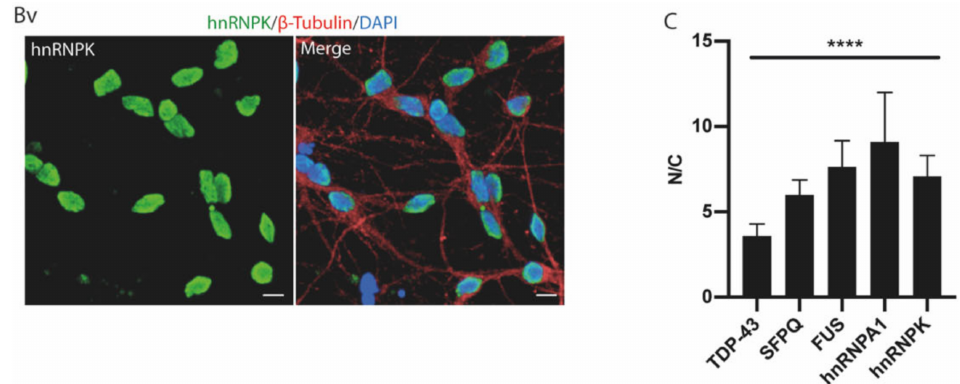
Figure 1. Localisation of amyotrophic lateral sclerosis (ALS)-linked RNA-binding proteins (RBPs) in human induced pluripotent stem cell (iPSC)-derived motor neurons. ( A ) Representative images of human iPSC-derived motor neurons immunolabeled with motor neuron markers SMI-32 and ChAT. Scale bars = 20 µ m. ( B ) Representative images of ALS-linked RBPs and neuronal marker β -III-tubulin in iPSC-derived motor neurons. Scale bars = 10 µ m. ( Bi ) TDP-43; ( Bii ) SFPQ; ( Biii ) FUS; ( Biv ) hnRNPA1; ( Bv ) hnRNPK. ( C ) The ratio of the average intensity of each RBP immunolabeling in the nucleus and cytoplasm was calculated by automated cell analysis. Data shown are mean nuclear / cytoplasmic ratios ( ± SD) from > 10,000 cells from 3 control lines in 3 independent experimental repeats. Data are plotted per well. **** = p < 0.0001, from a Brown–Forsythe